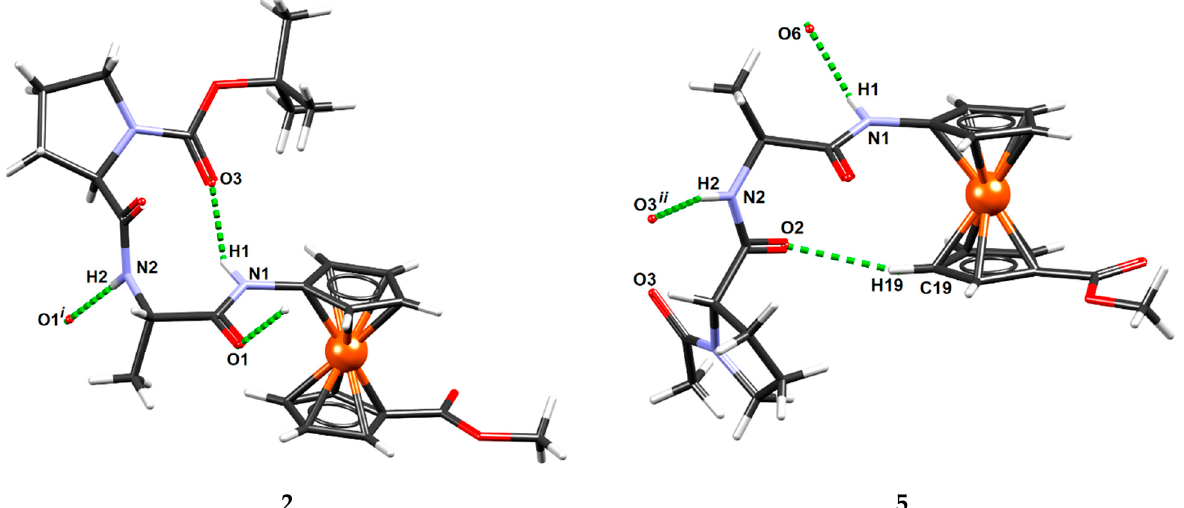
Figure 12. Conformations of peptides 2 and 5 determined by X-ray structure analysis. Hydrogen bonds are shown as green dashed lines. Symmetry operators: (i) − 1 + x, y, z; (ii) ½ − x, ‒ ½ + y, − z.